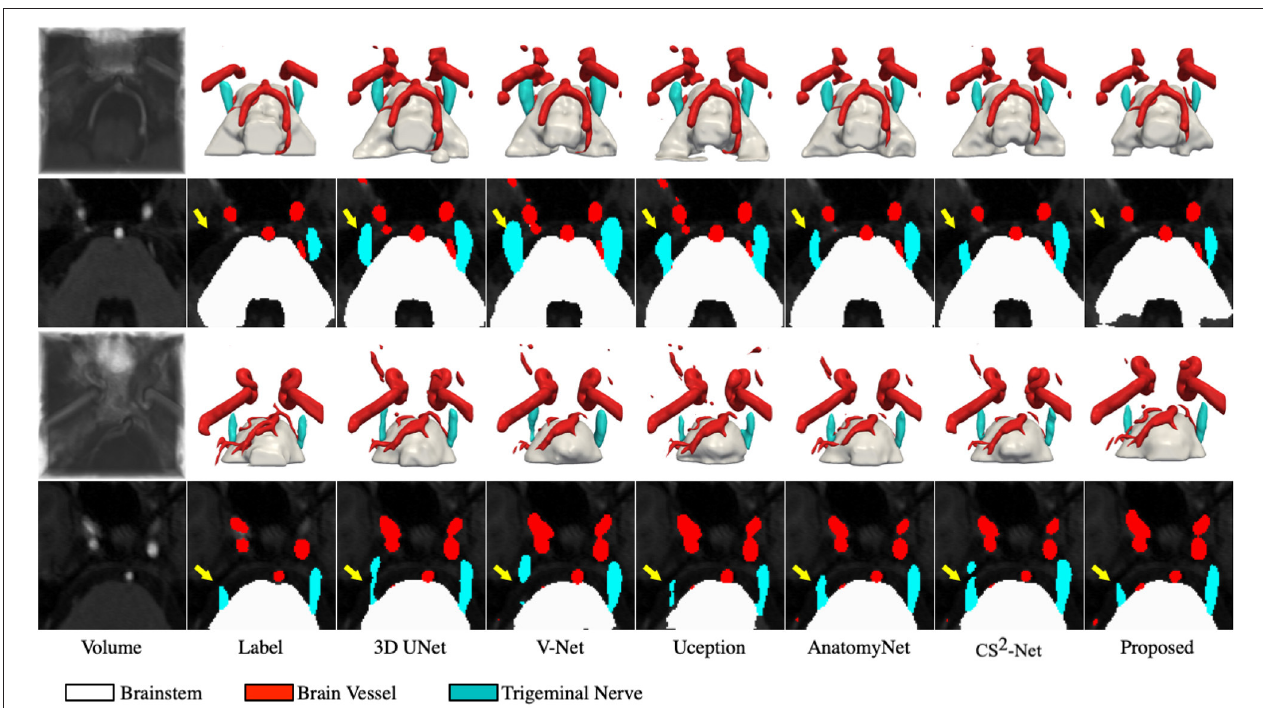
FIGURE 3 | Visualization of the segmentation results. The first and third rows represents the 3D rendering of two segmentation volumes, and the second and fourth rows correspond to the 20 and 14 th slices of the two segmentation volumes, respectively. From left to right in each column: the cropped MRA volumes and the corresponding intermediate slices, the ground truths, the segmentation results of 3D UNet, V-Net, Uception, AnatomyNet, CS 2 -Net and the proposed method.